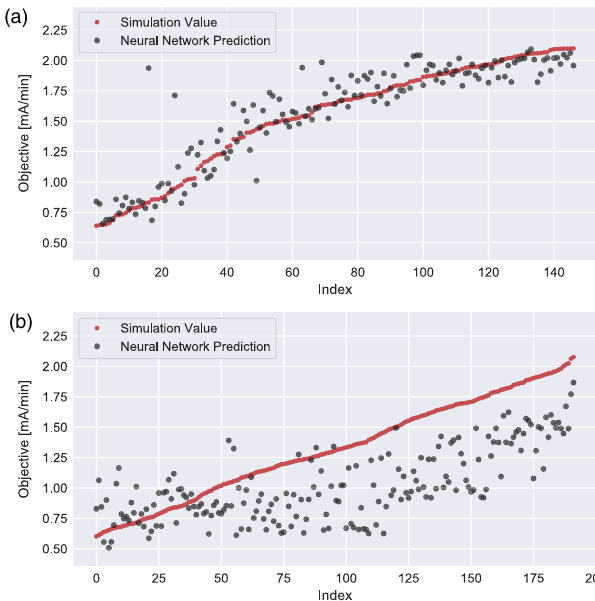
FIG. 9. Comparison of deterministic NN predictions on (a) in- sample test dataset samples and (b) OOD dataset samples.